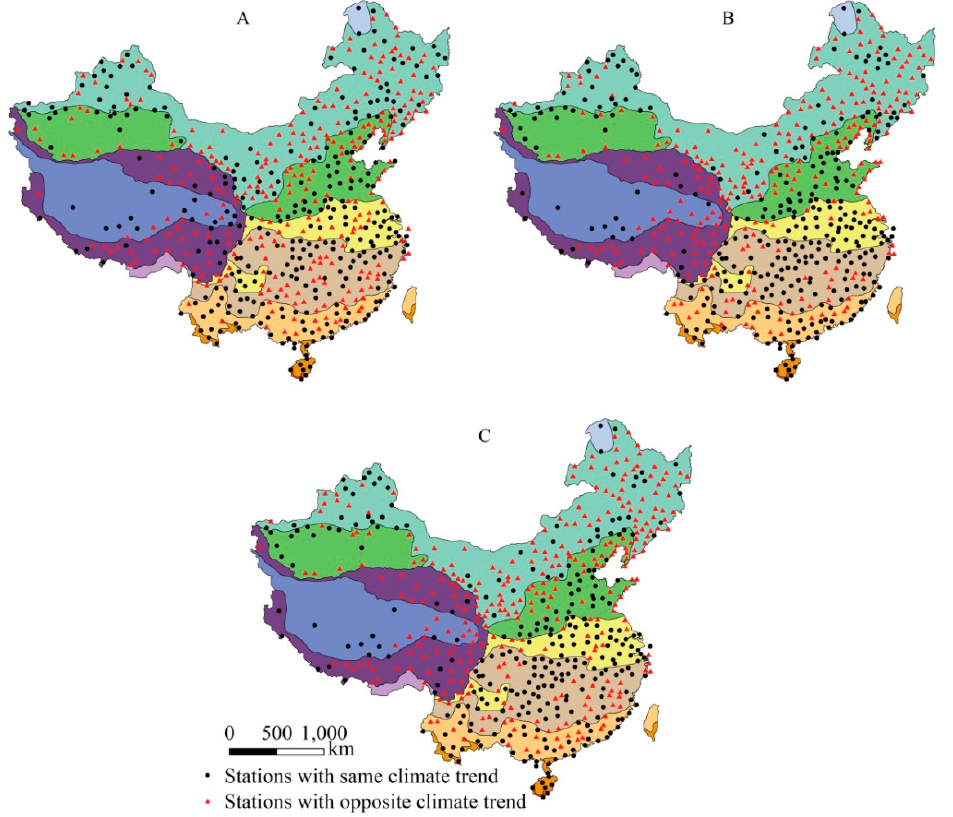
Figure 13. Climate trend of first frost day ( A ), last frost day ( B ) and frost-free period ( C ).